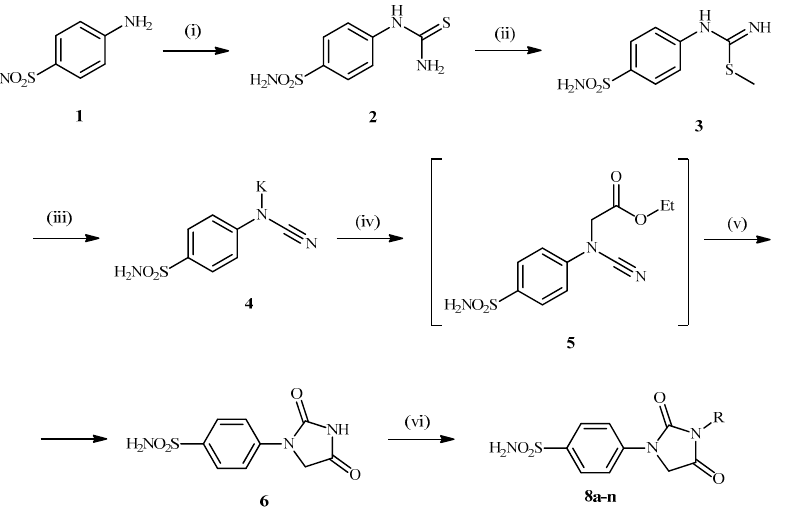
Table 1. Inhibition data of human CA isoforms hCA I, II, and VII and fungal β -CA isoforms MgCA, from M. globosa , and CgNce103, from C. glabrata , with compounds 6 and 8a – n in comparison with AAZ as standard drug by a stopped flow CO 2 hydrase assay [67].